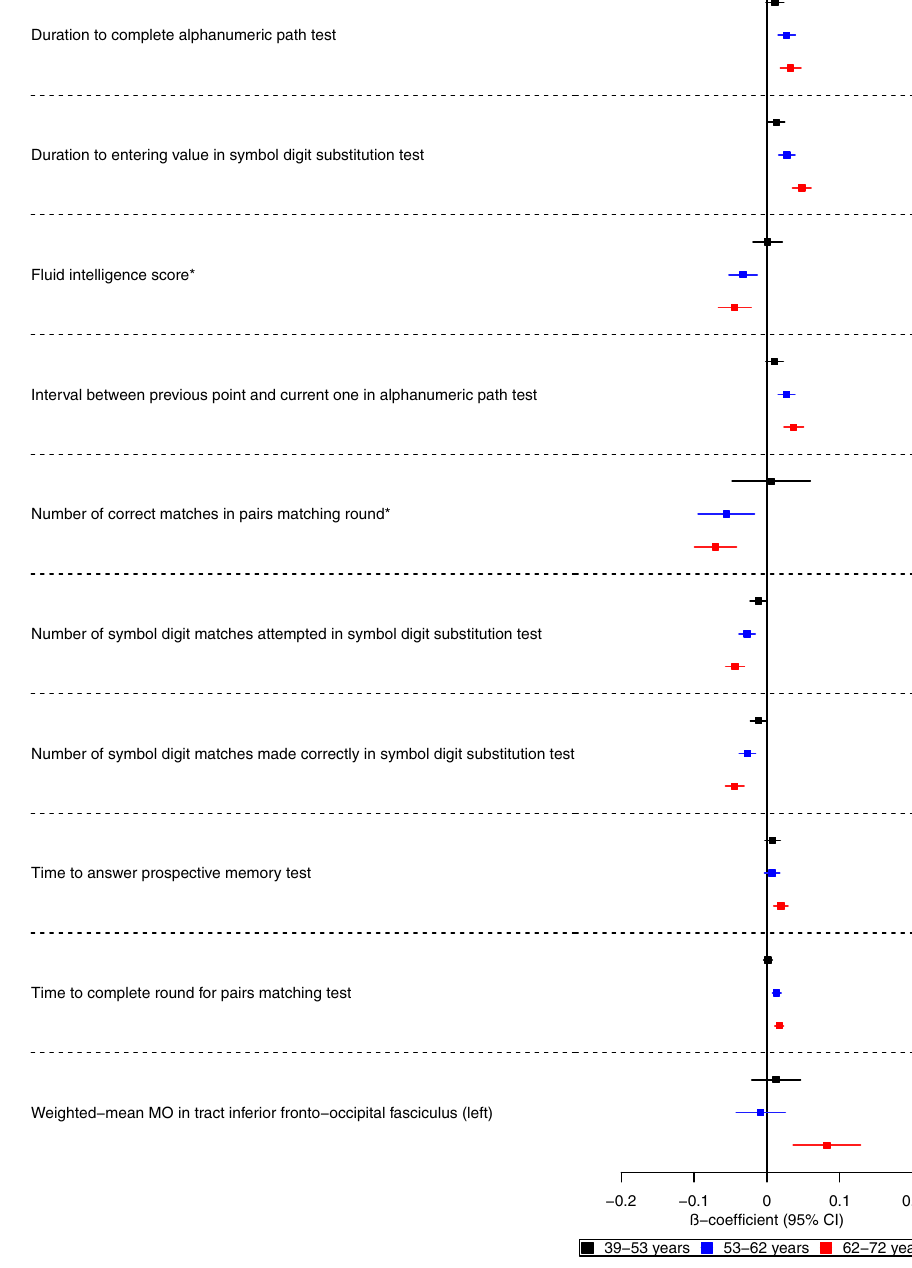
con fi dence intervals. All statistical tests were two-sided. *Effect estimates were derived from ordered logistic models, and effect estimates are on the log-odds scale. We found evidence that the polygenic risk score for Alzheimer ’ s disease is related to some cognitive measures inall ageranges examined.Thismaysuggest a bidirectional relationship between cognitive measures and Alzheimer ’ s